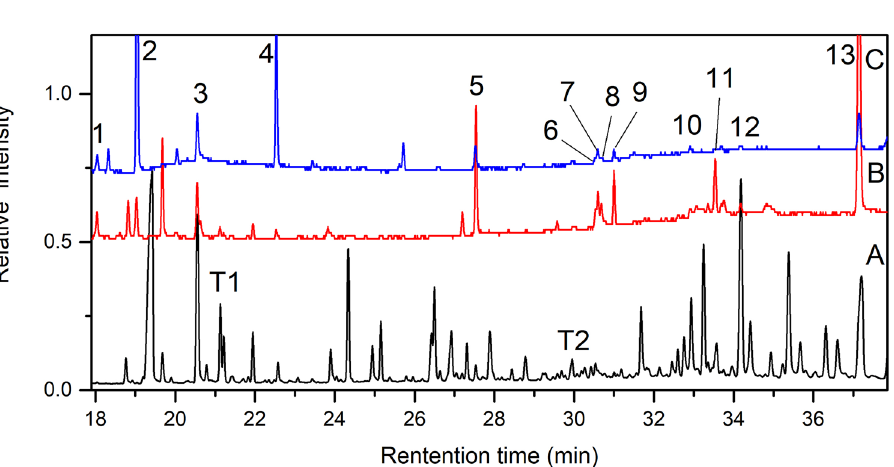
Figure 7. TIC chromatogram obtained by GC/MS of A—modern tea; B—modern tea residue; C—sample CST; T1, T2: two derivatized peaks of theanine in modern tea sample (A); The peak numbers are corresponding to the numbers in Table